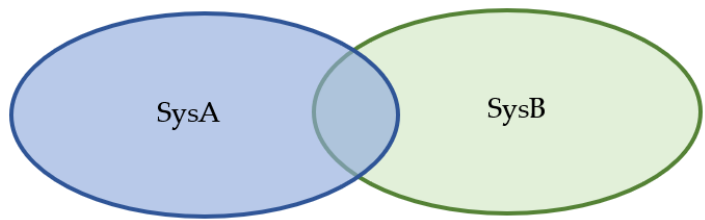
Figure 2. Representation of the sets of systematic failures of channels A and